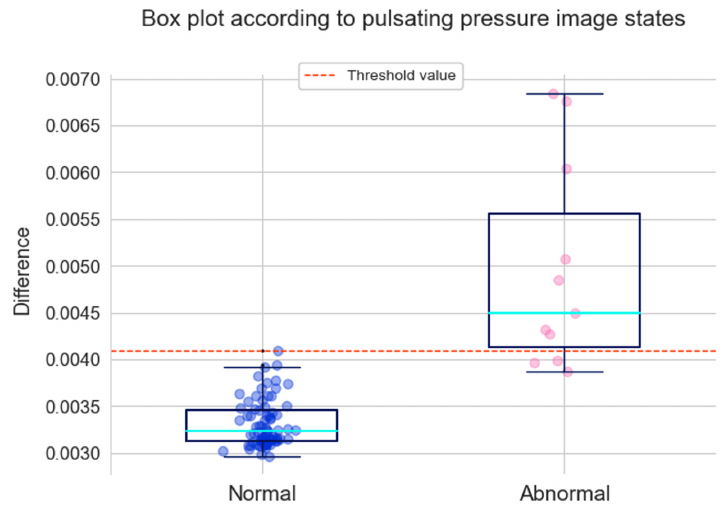
Figure 12. Box plot of CNN autoencoder according to pulsating pressure image states.